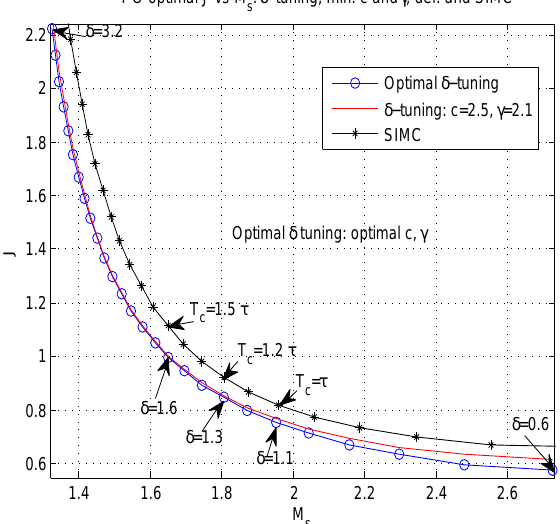
Figure 5: Illustration of performance index J as a func- tion of sensitivity index M s . The optimal δ - tuning algorithm with optimal and varying ¯ c snd γ parameters as well as the setting with ¯ c = 2 . 5 and γ = 2 . 1. SIMC algorithm also illustrated. DIPTD plant with K = 1